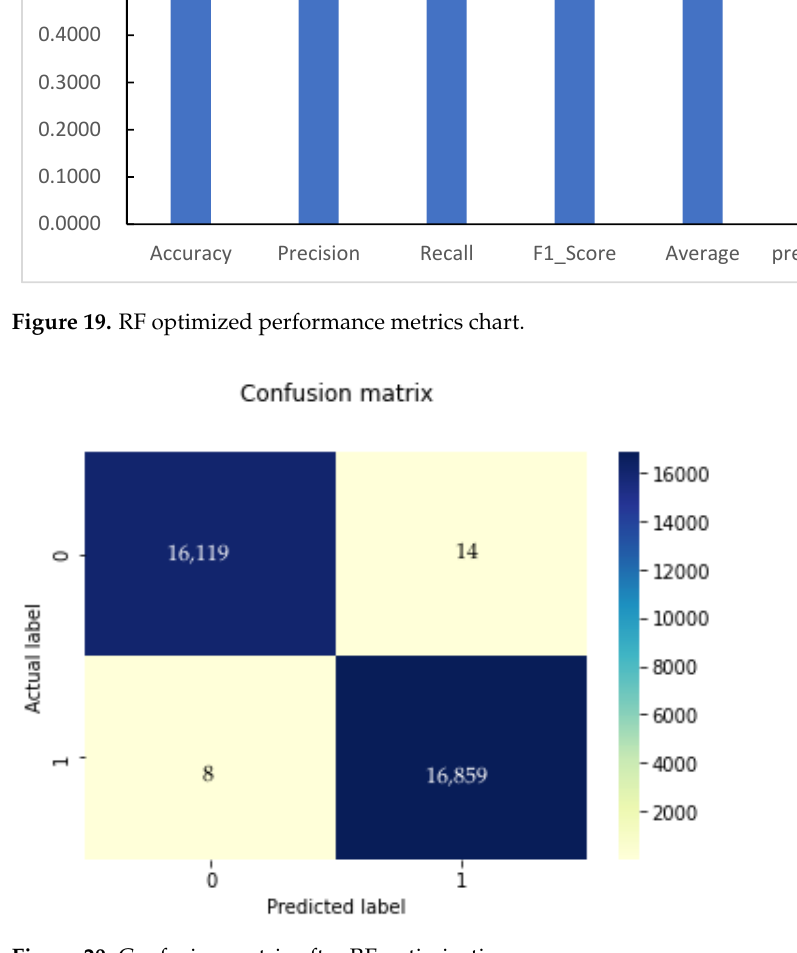
Figure 20. Confusion matrix after RF optimization.